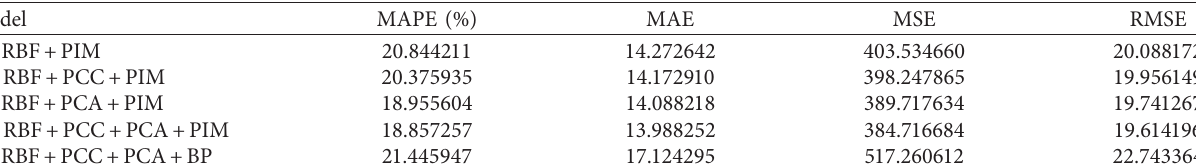
Table 4: Performance comparison in WPM.